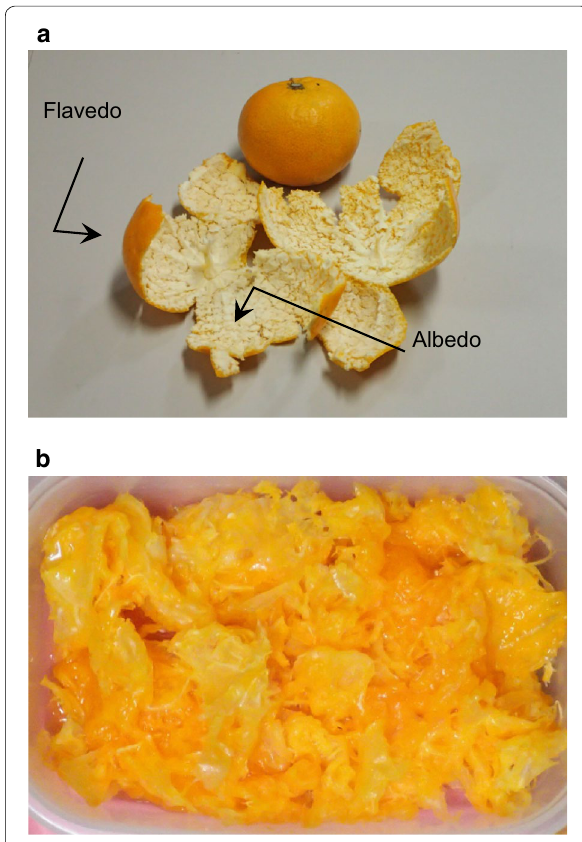
Fig. 1 Flavedo and albedo are removed before squeezing ( a ) and after squeezing (strained lees) ( b